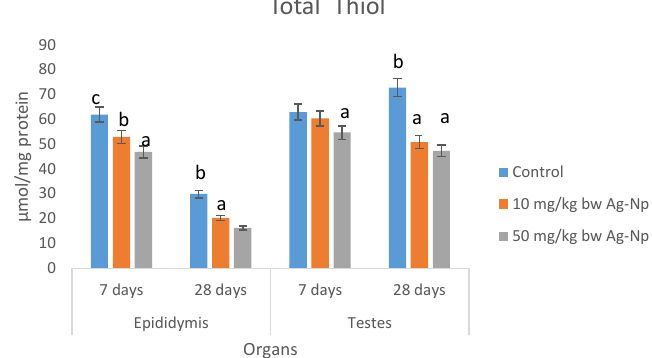
Figure 4. Effects of sub-dermal administration of Ag-NPs on total thiol levels in the testis and epididymis of rats. Each bar represent mean ± standard deviation of triplicate determination. Bars with different superscript alphabet are significantly different ( p < 0.05). The high significant levels of the parameters were in the order of a < b < c. Data with superscript alphabet “a” are significantly lower than data with superscript alphabet “b” while data with superscript “b” are lower than data with superscript alphabet “c” at p < 0.05.